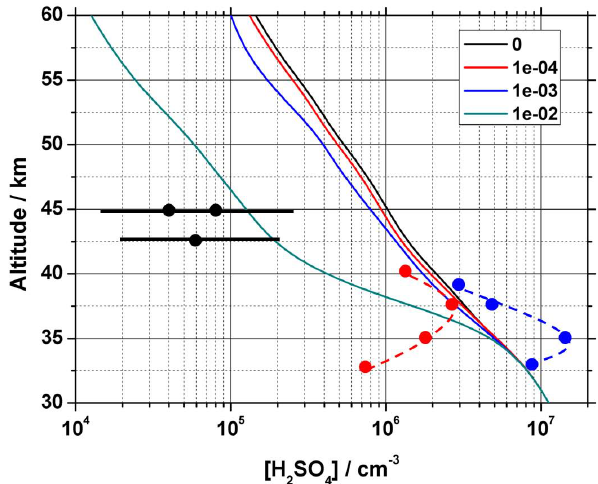
Fig. 7. Altitude profiles at 44 ◦ N of the H 2 SO 4 concentration mod- elled in UMSLIMCAT with the heterogeneous uptake coefficients ( γ ) of H 2 SO 4 on MSPs indicated in the legend. The solid points are balloon-borne measurements (blue – Viggiano and Arnold, 1981; red – Schlager and Arnold, 1987; black, with error bar – Arijs et al.,